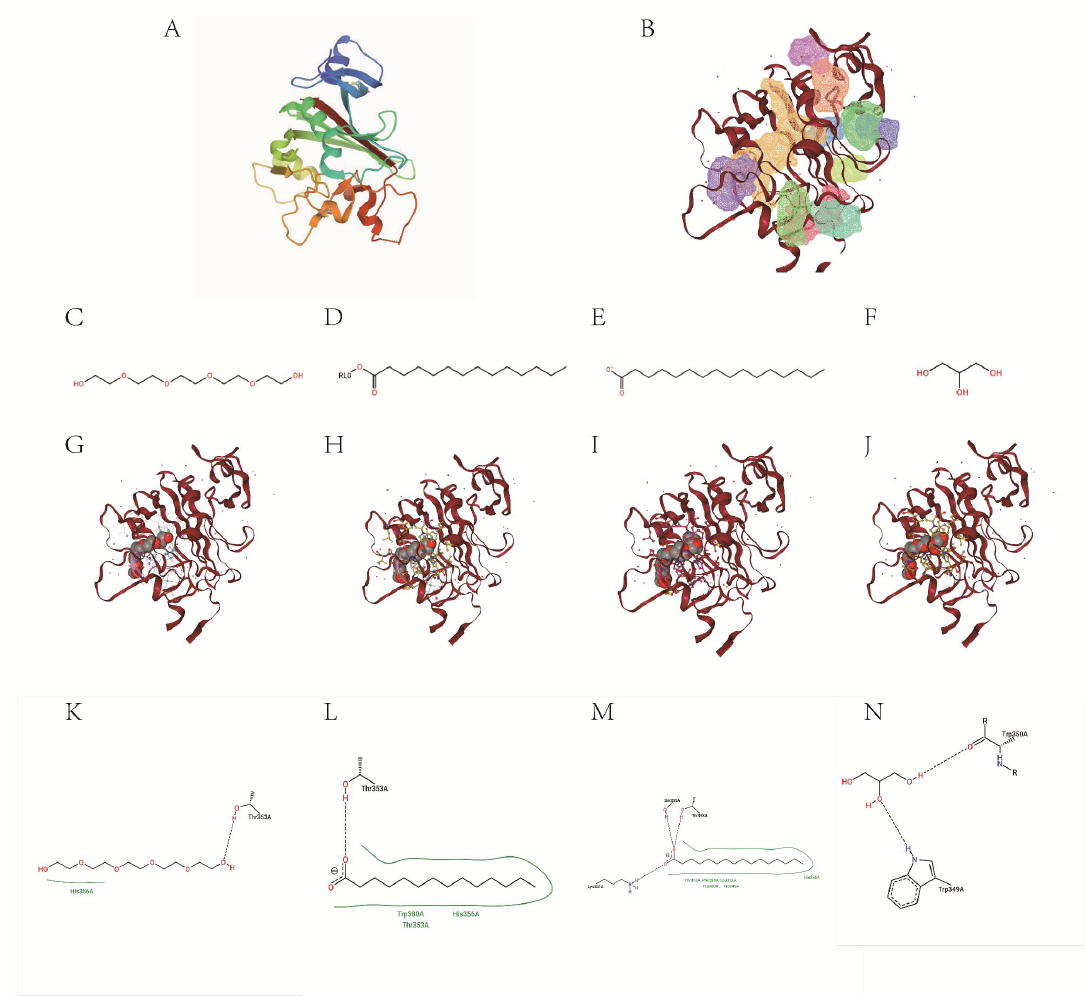
Figure 8. Potential small molecule compounds targeting ANGPTLs4. ( A ) The three-dimensional structure of ANGPTLs4 protein (Protein Data Bank). ( B ) Eleven predicted pockets of ANGPTLs4 (Proteins Plus). ( C – F ) The chemical formulas of four potential small molecule compounds targeting ANGPTLs4. ( G – J ) The three-dimensional structure revealing the combination of ANGPTLs4 and four potential small molecule compounds. ( K – N ) The two-dimensional chemical formulas revealing the combination. ( C , G , K ) Pentaethylene glycol. ( D , H , L ) Myristic Acid. ( F , I , M ) Palmitic Acid. ( F , J , N ) Glycerol.